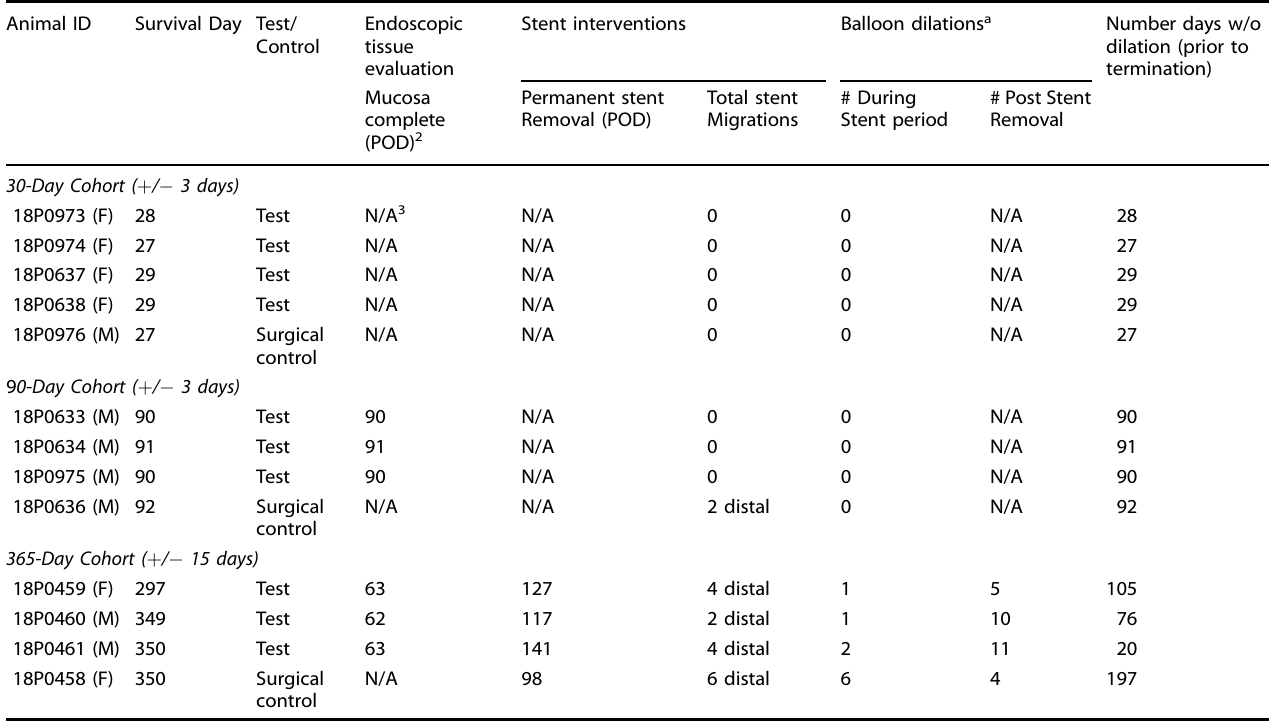
Table 2. Summary of endoscopic